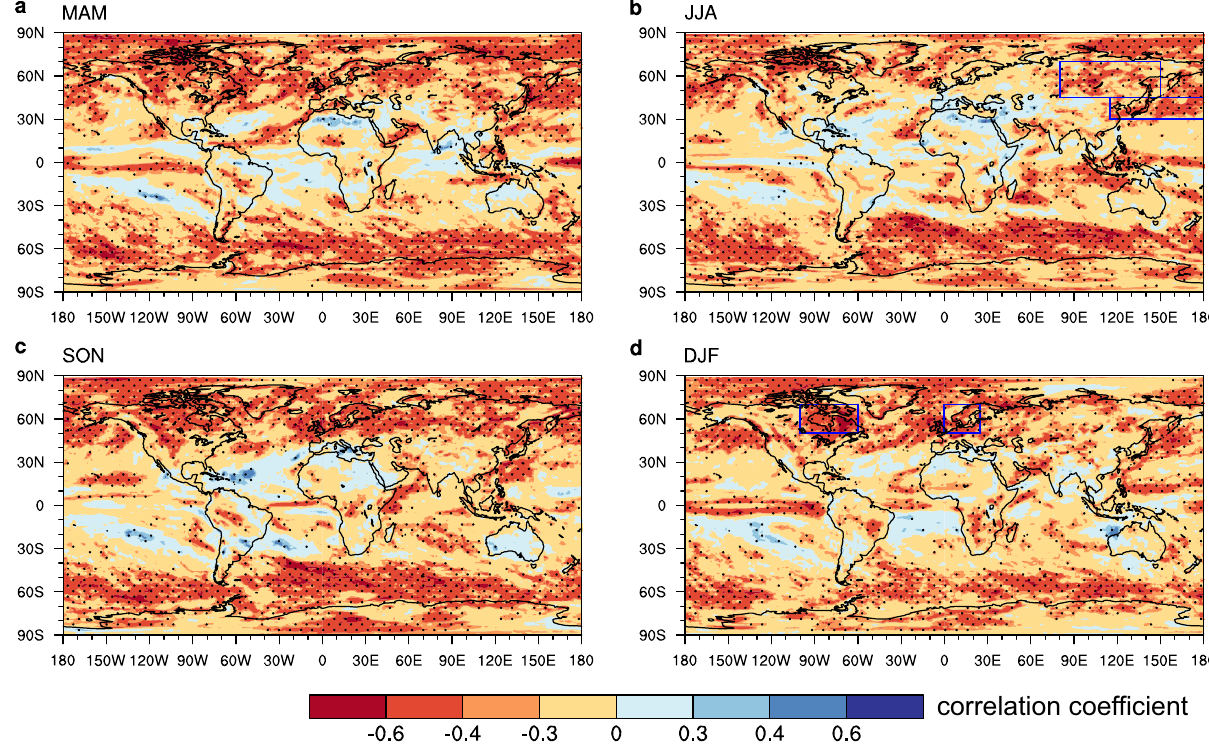
Fig.1|Theemergentrelationshipinmodelsimulations. Inter-modelcorrelation betweenthepresent-dayprecipitation(pr5d)variabilityandtheprobabilityratioof extreme precipitation changes under a 3°C global warming increment in the joint ensemble of CMIP5 and CMIP6 (Coupled Model Intercomparison Project Phases 5 and 6) using Representative Concentration Pathway 8.5 (RCP8.5) and Shared Socioeconomic Pathway 5-8.5 (SSP5-8.5) scenario projections, respectively. Differ- ent seasons are considered, for March-to-May (MAM; a ), June-to-August (JJA; b ), September-to-November (SON; c ) and December-to-February (DJF; d ). Here